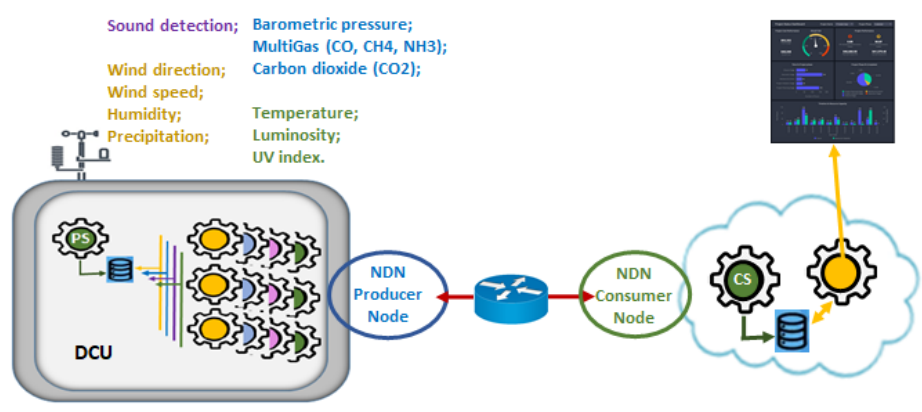
Figure 2. IoT data gathering typical